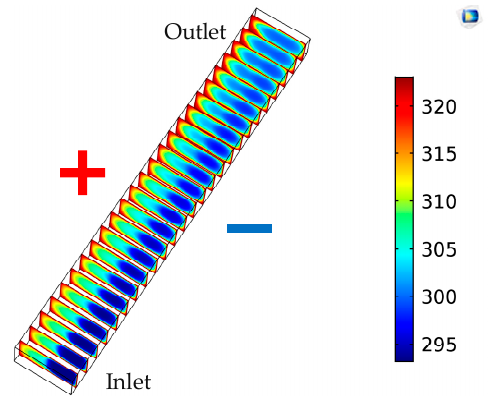
Figure 3. Temperature distribution of various x – z planes along the y -direction.